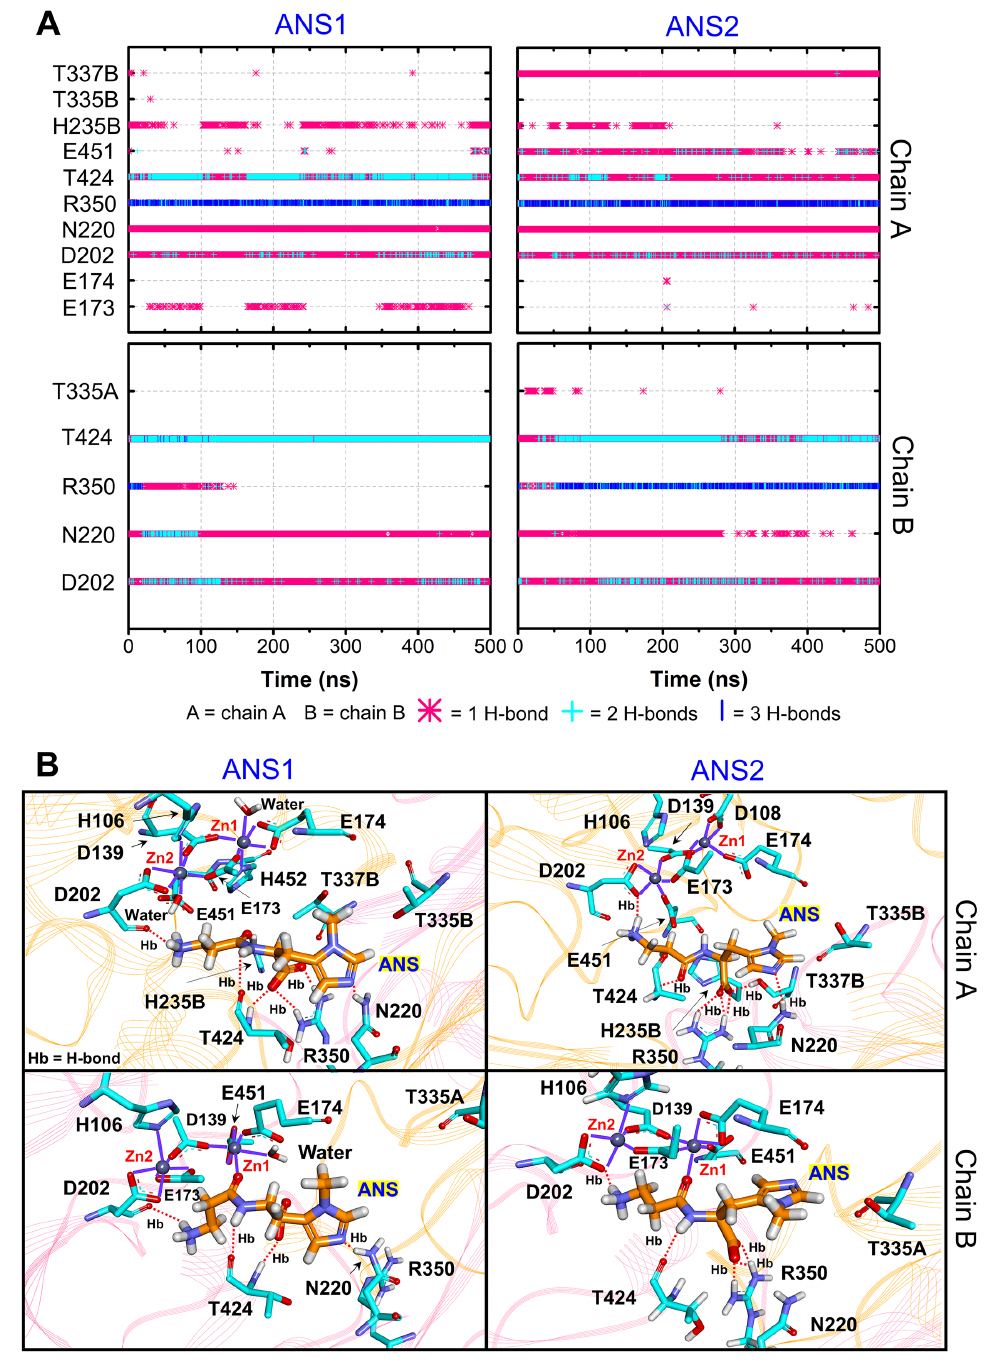
Figure 4 CN1-ANS interactions. (A) Hydrogen bonds between anserine in both repeats (ANS1 and ANS2) and key residues. The locations of key components are displayed in (B). The purple lines show residues and waters that are within 3 Å of dizinc ions. The red dashed lines indicate the hydrogen bonds